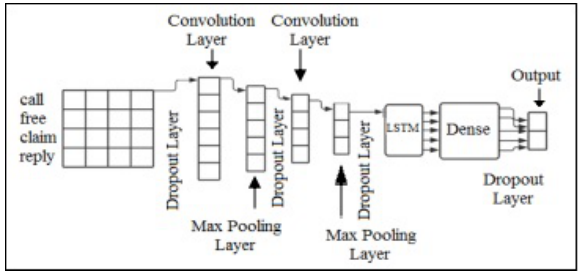
Fig. 5. Proposed CNN LSTM